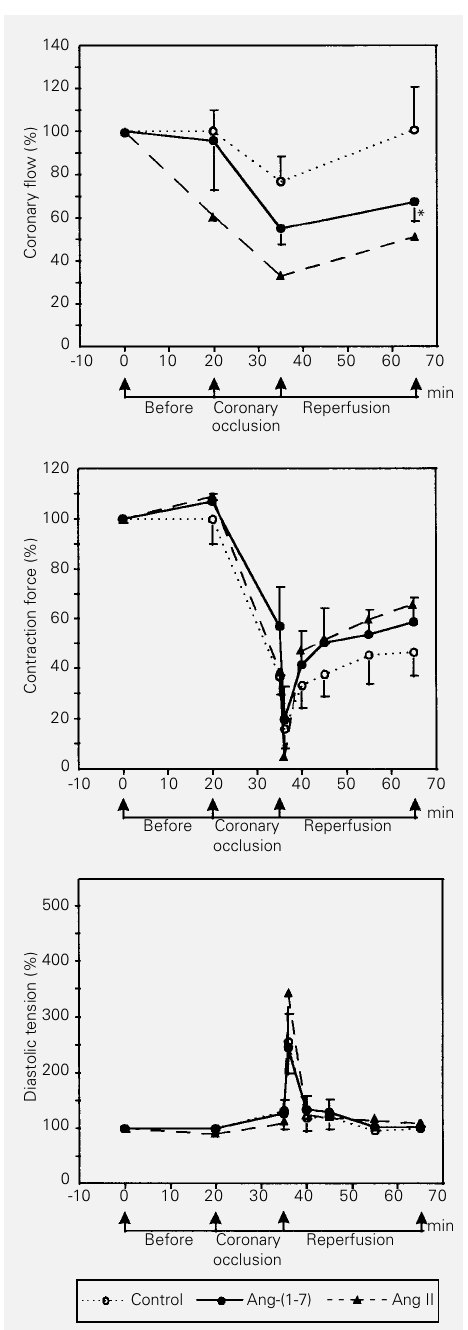
Figure 3 - Coronary flow (upper), contraction force (middle) and diastolic tension (lower) in iso- lated rat hearts perfused with low-Ca 2+ Krebs-Ringer solution (control, N = 5), low-Ca 2+ Krebs- Ringer solution containing 27 nM Ang-(1-7) (N = 4) or low-Ca 2+ Krebs-Ringer solution containing 27 nM Ang II (N = 2) before and after (reperfusion) coronary oc- clusion. Percentage was calcu- lated in relation to the last value at the equilibration period. *P<0.05 compared to the con- trol group (ANOVA followed by the Least Significant Difference